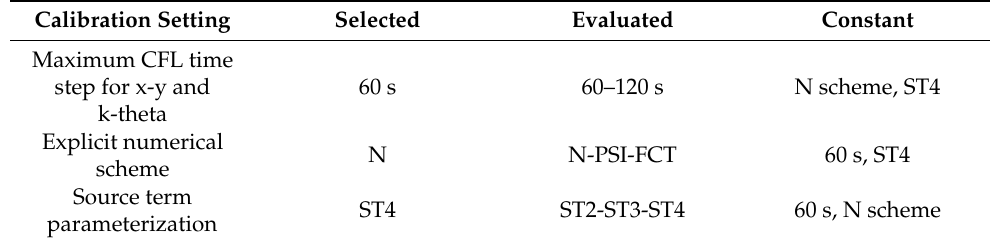
Table 8. Settings evaluated and kept constant in the calibration process and final selection.